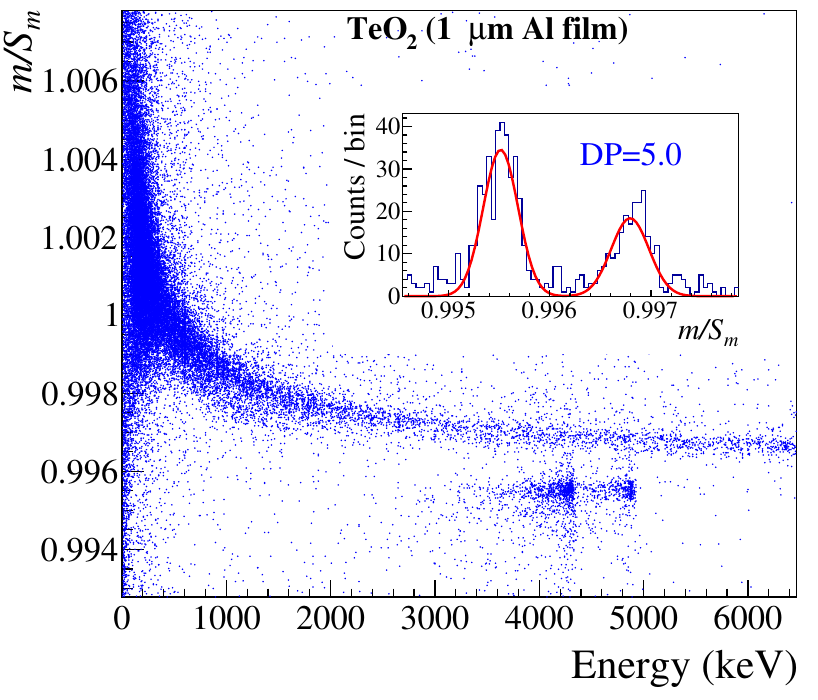
Figure 7 . The parameter m=S m (see text) is plotted as a function of the energy for a TeO 2 bolometer (Detector 3 in table 1). The two lines of the uranium source, which irradiates the 1 (cid:22) m thick Al (cid:12)lm, are clearly separated from bulk events. As for the energy of the (cid:11) events,